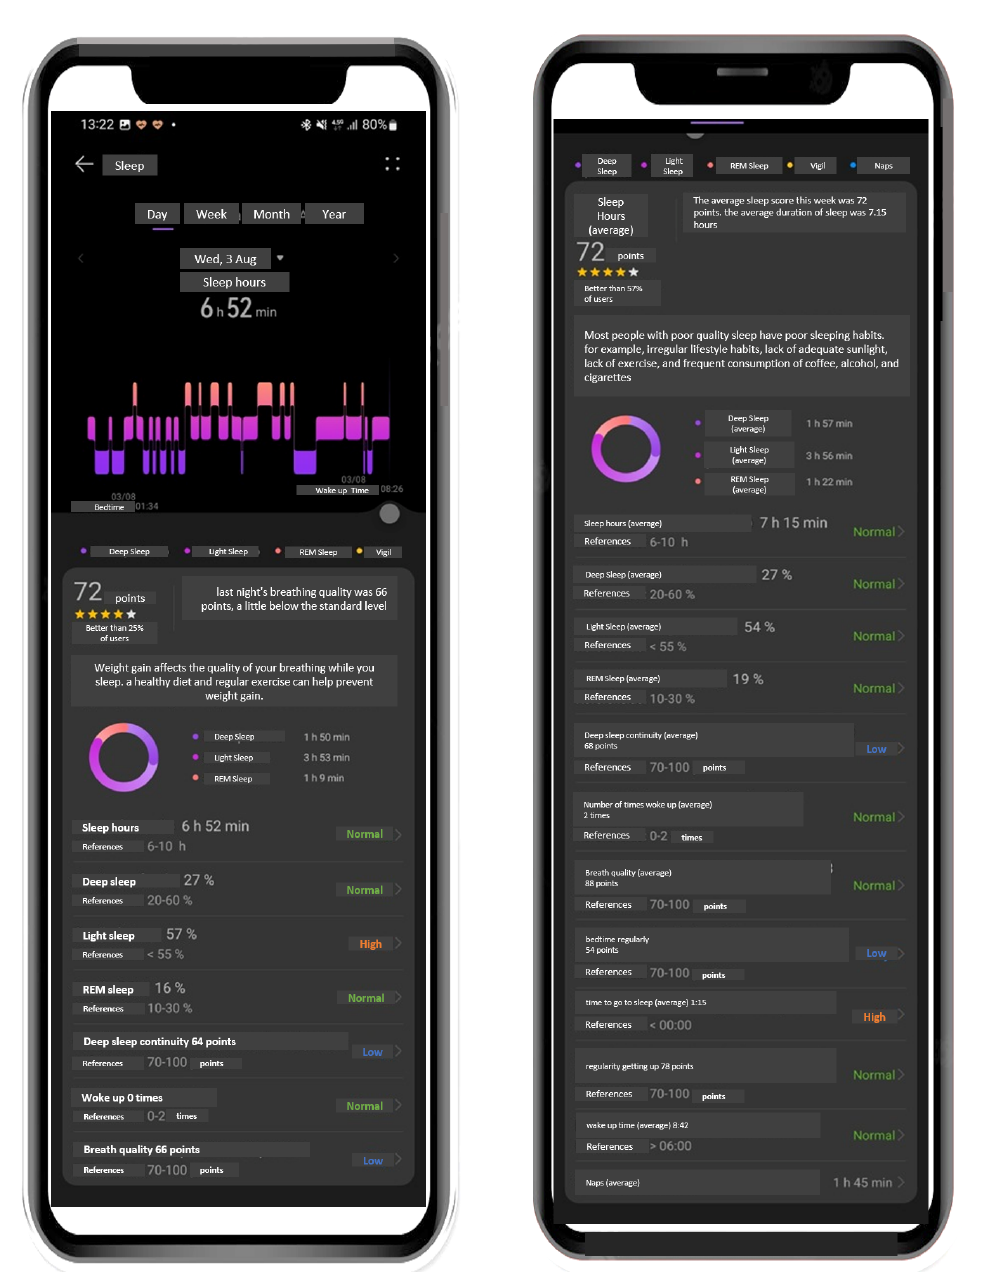
Figure 17. Example of a sleep improvement application with the sensor network for a user. Screen- shots of the cell phone corresponds to no sensor